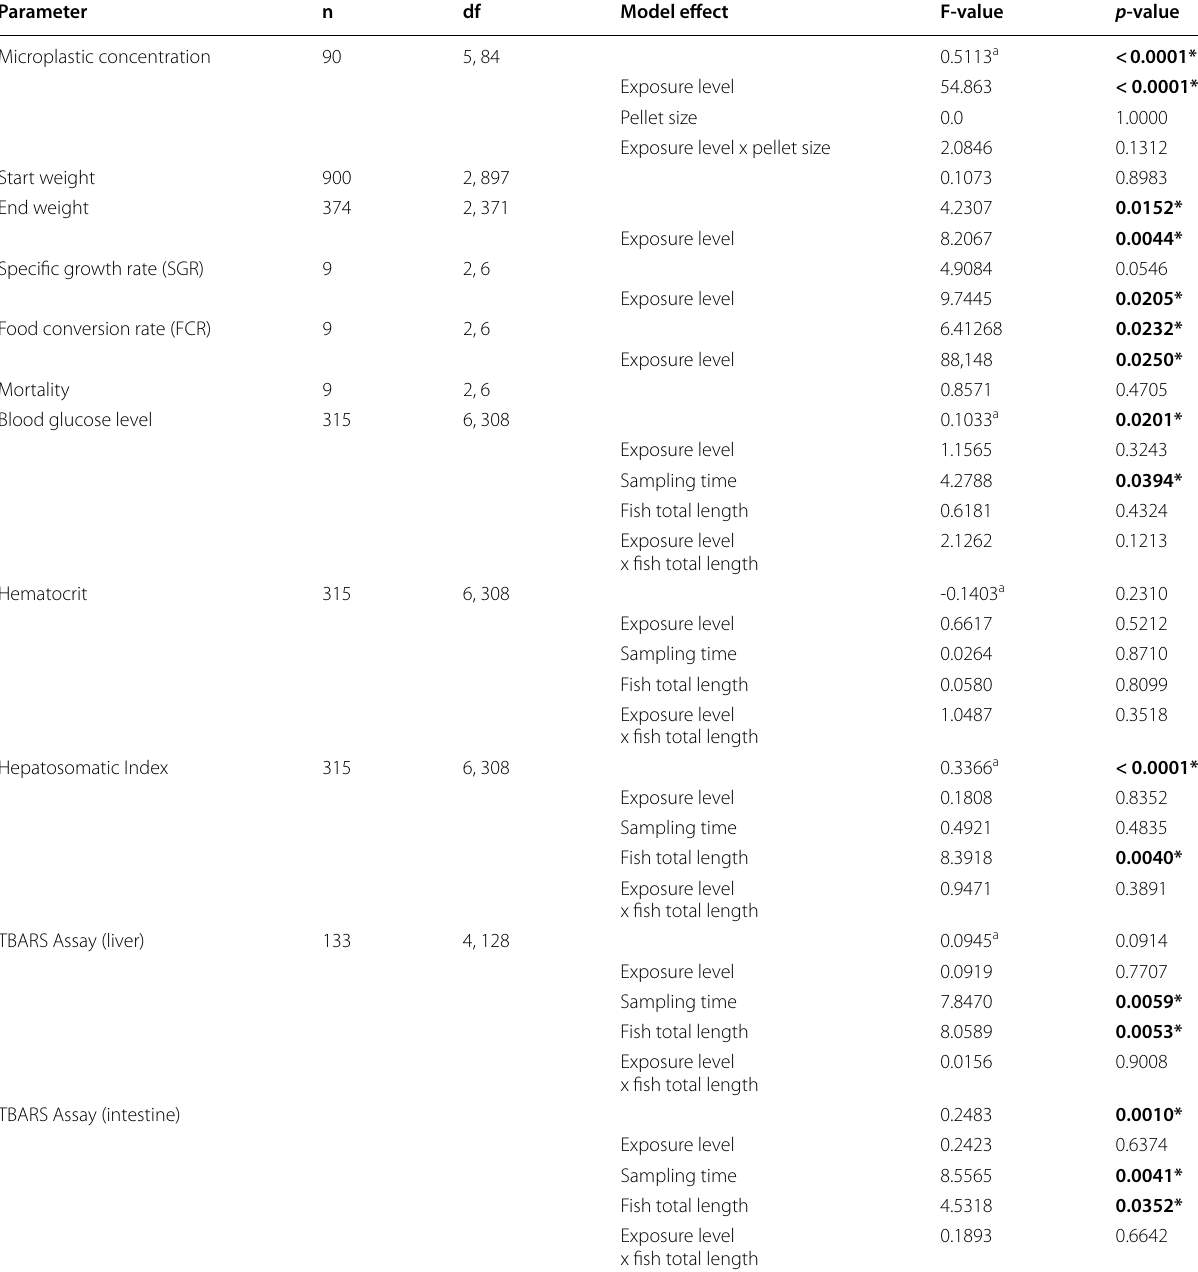
number of observations. df degrees = =